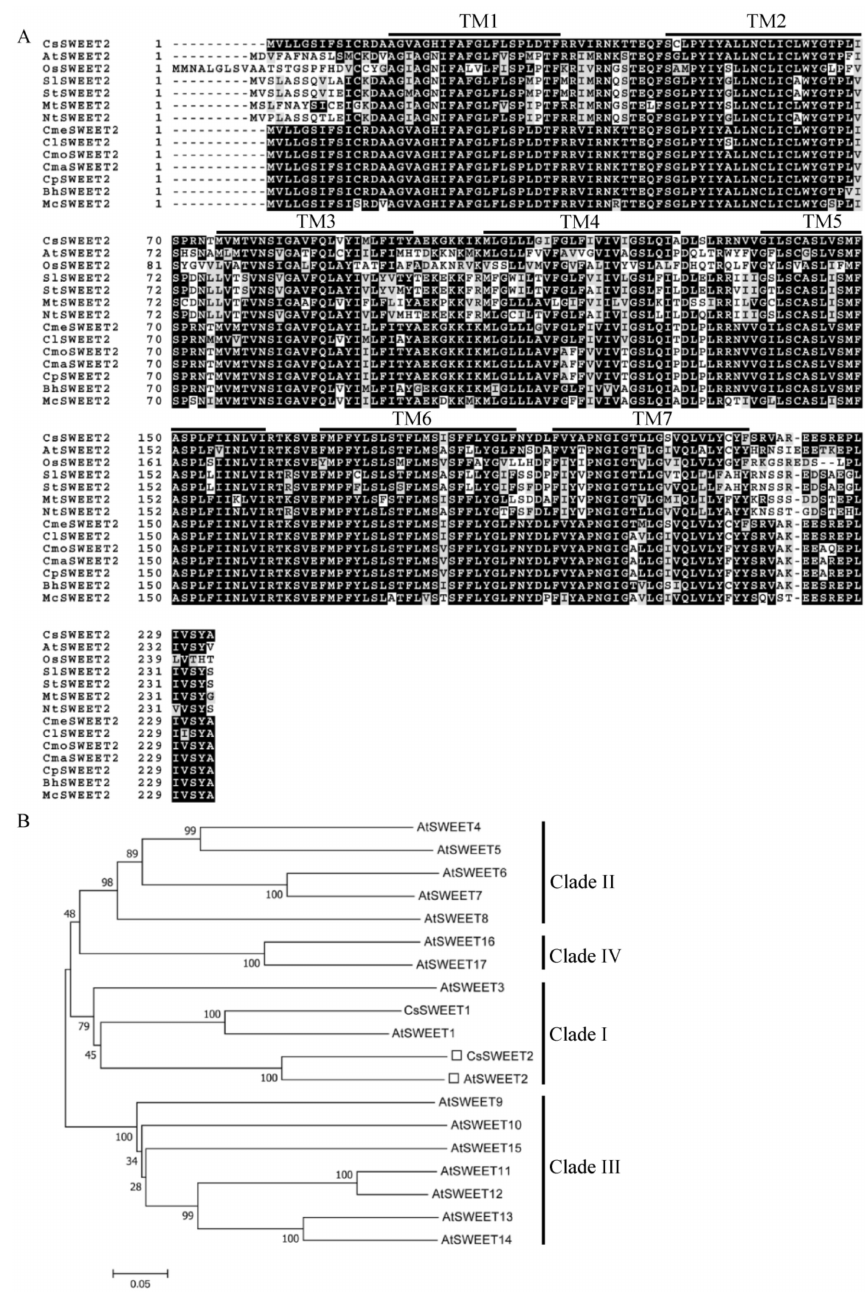
Figure 1. Sequence analysis of CsSWEET2. ( A ) Multiple sequence alignment of SWEET2 pro- teins from Cucumis sativus (CsSWEET2), Arabidopsis thaliana (AtSWEET2), Oryza sativa (OsS- WEET2), Solanum lycopersicum (SlSWEET2), Solanum tuberosum (StSWEET2), Medicago truncatula (MtSWEET2), Nicotiana tabacum (NtSWEET2), Cucumis melo (CmeSWEET2), Citrullus lanatus (ClSWEET2), Cucurbita moschata (CmoSWEET2), Cucurbita maxima (CmaSWEET2), Cucurbita pepo (CpSWEET2), Benincasa hispida (BhSWEET2), and Momordica charantia (McSWEET2). The seven transmembrane domains (TMs) are outlined. The conserved amino acids are indicated by the grey background, and identical amino acids are denoted by the dark shading. ( B ) Phylogenetic analysis of SWEET proteins from cucumber (CsSWEET2) and Arabidopsis (AtSWEET1 to AtSWEET17). The amino acid sequences of the SWEET proteins used for the analysis are listed in Table